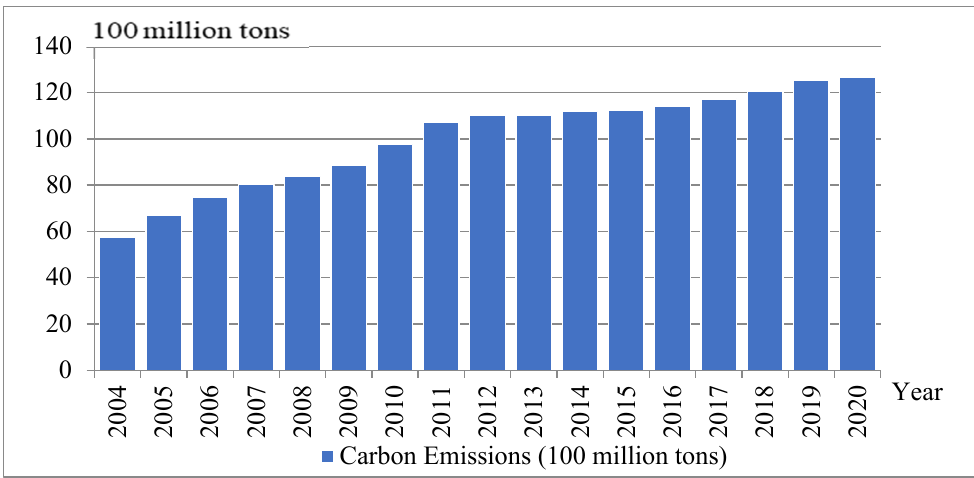
Table 2. Proportion of carbon emissions in major countries in 2020.